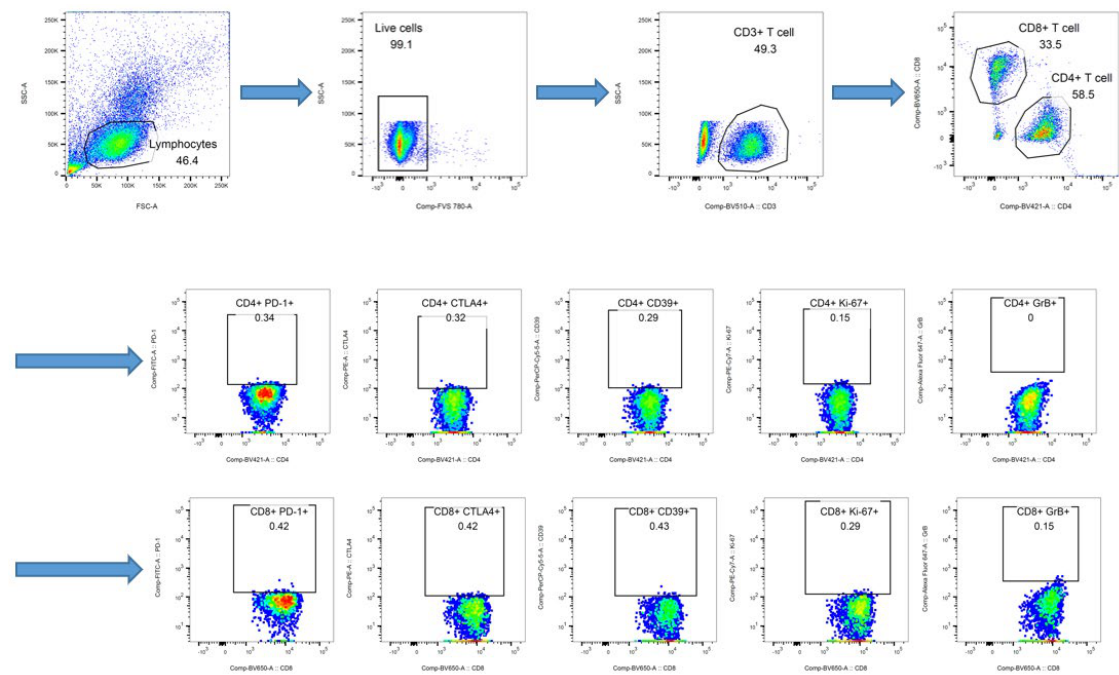
Figure A2. Immune cell analysis protocol (panel 2).